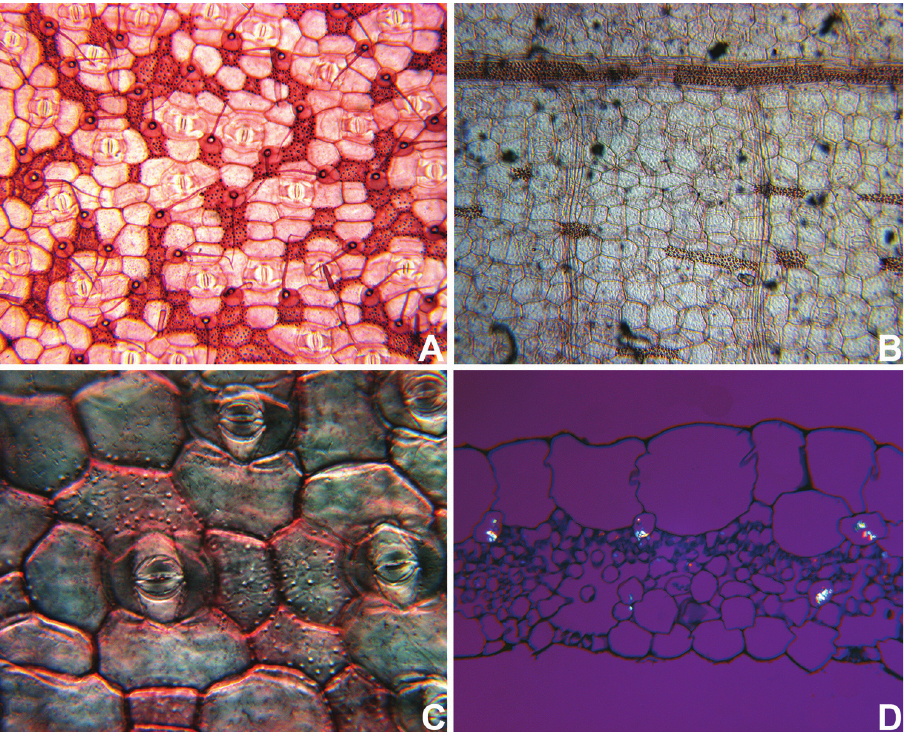
Figure 2. Anatomical characters used in the phylogenetic analysis. A leaf epidermis with silica crystals in specialized cells with thickened cell walls (Character 103–104), in Callisia multiflora (M.Martens & Gale- otti) Standl B leaf epidermis with silica crystals in specialized cells without thickened cell walls (Character 103–104), bundle sheath in the mesophyll with longitudinal sclerenchymatic extensions (Character 105), in Gibasis pellucida (M.Martens & Galeotti) D.R.Hunt. C detail of the silica crystals in the leaf